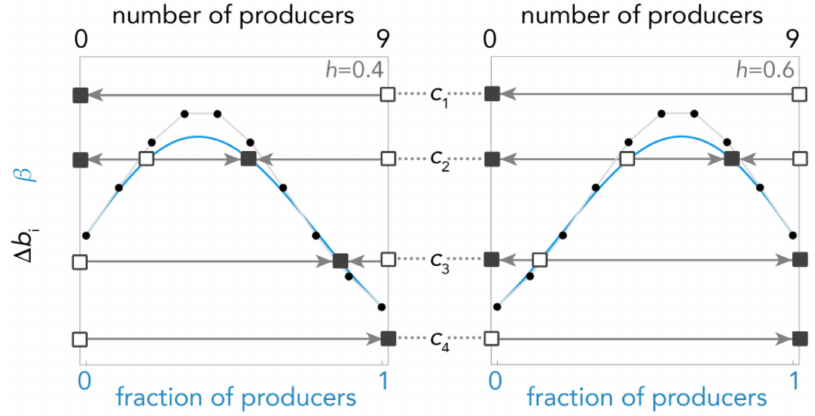
Figure 3. Types of dynamics when the benefit is a sigmoid function. The gradient of selection β (continuous blue line) and its Bernstein coefficient ∆ b i (dotted line); squares show the equilibria (full: stable; empty: unstable) for different values of c (gray lines); arrows show the direction of the dynamics (determined by the sign of the gradient of selection); s = 5; n = 9, h = 0.4 or 0.6.